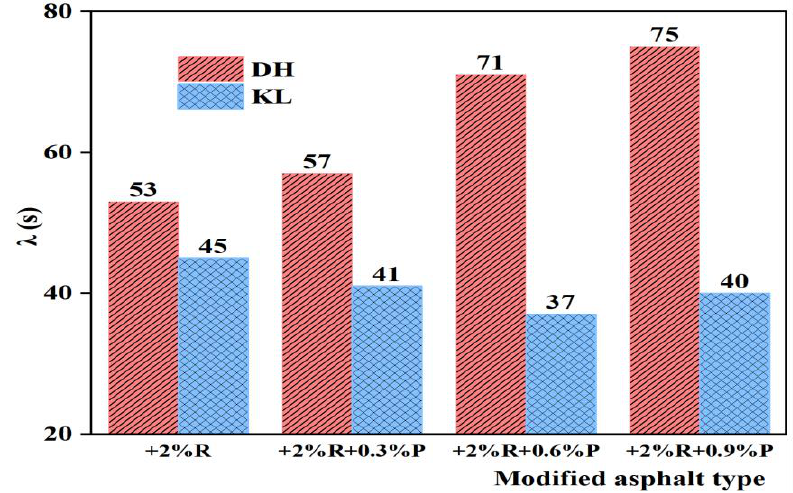
Figure 17. The λ value of composite modified asphalt with different PPA/SBR dosages.